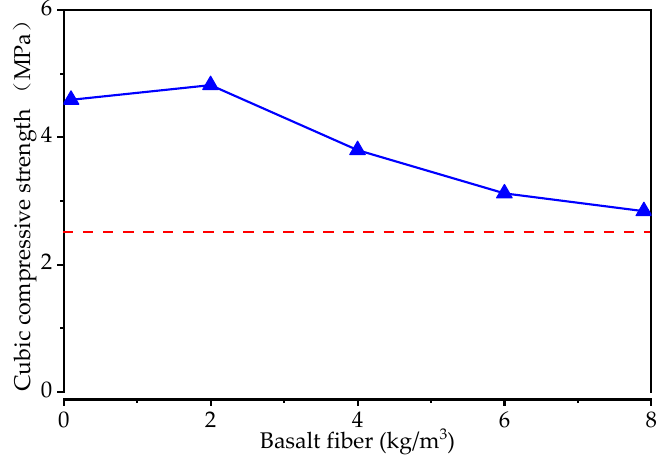
( b ) Figure 6. The flexural tensile failure patterns of ( a ) concrete prism without basalt fiber and ( b ) con- crete prism with basalt fiber. The effect of basalt fiber on the flexural tensile strength of the pervious concrete is presented in Figure 7. The flexural tensile strength increases and then decreases with the increasing of the basalt fiber content. The maximum strength value is 4.82 MPa when the basalt fiber content is 2 kg/m 3 , and then the strength value decreases to 2.84 MPa for the basalt fiber content of 8 kg/m 3 . In CJJ/T 135-2009 [43], it is stated that the flexural tensile strength should not be lower than 2.5 MPa (the red dashed line in Figure 7), meaning that